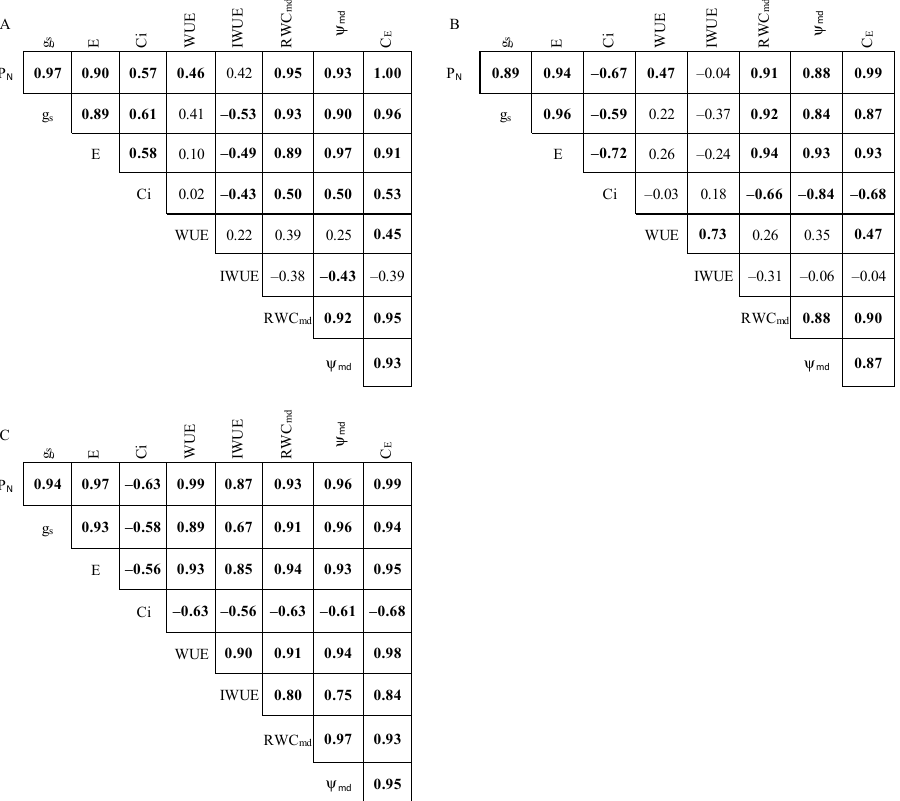
Figure 3. Correlation matrix of ( A ) Ailanthus altissima (AA), ( B ) Phytolacca americana (PA), and ( C ) Robinia pseudoacacia (RP). Net photosynthetic rate (P N ), stomatal conductance (g s ), transpiration rate (E), sub-stomatal CO 2 concentration (C i ), water use efficiency (WUE), intrinsic water use efficiency (IWUE), midday relative water content (RWC md ), midday leaf water potential ( ψ md ), and apparent carboxylation efficiency (C E ). Bold values indicate a significant correlation ( p < 0.05).